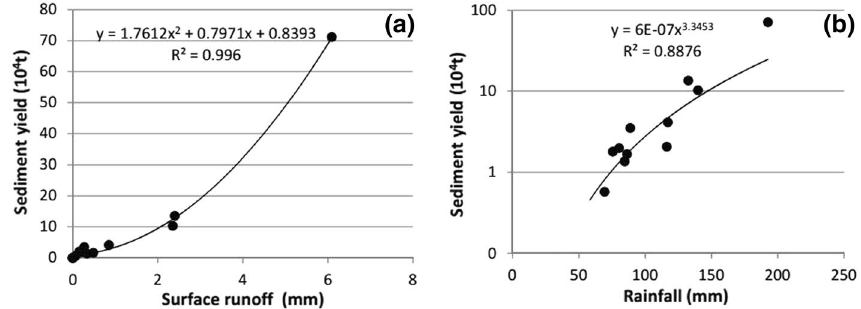
Fig. 10 Correlation of sediment yield with a surface runoff b